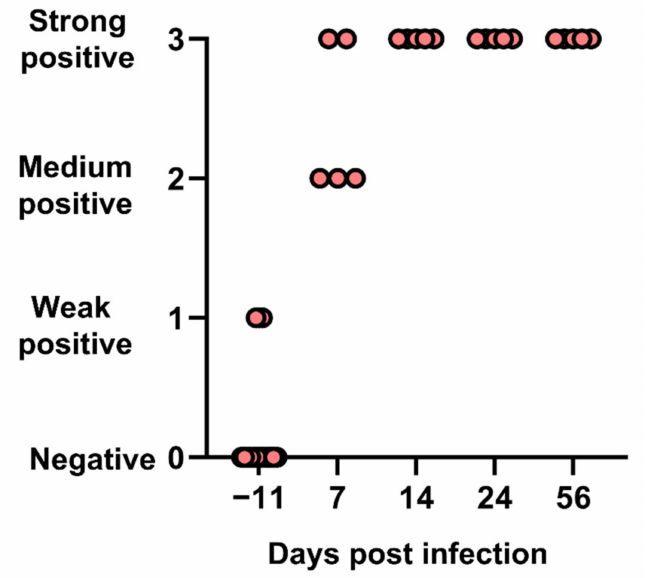
Figure 5. Immunofluorescence antibody (IFA) results in cats after experimental infection with FeMV- GT2 on day 0.